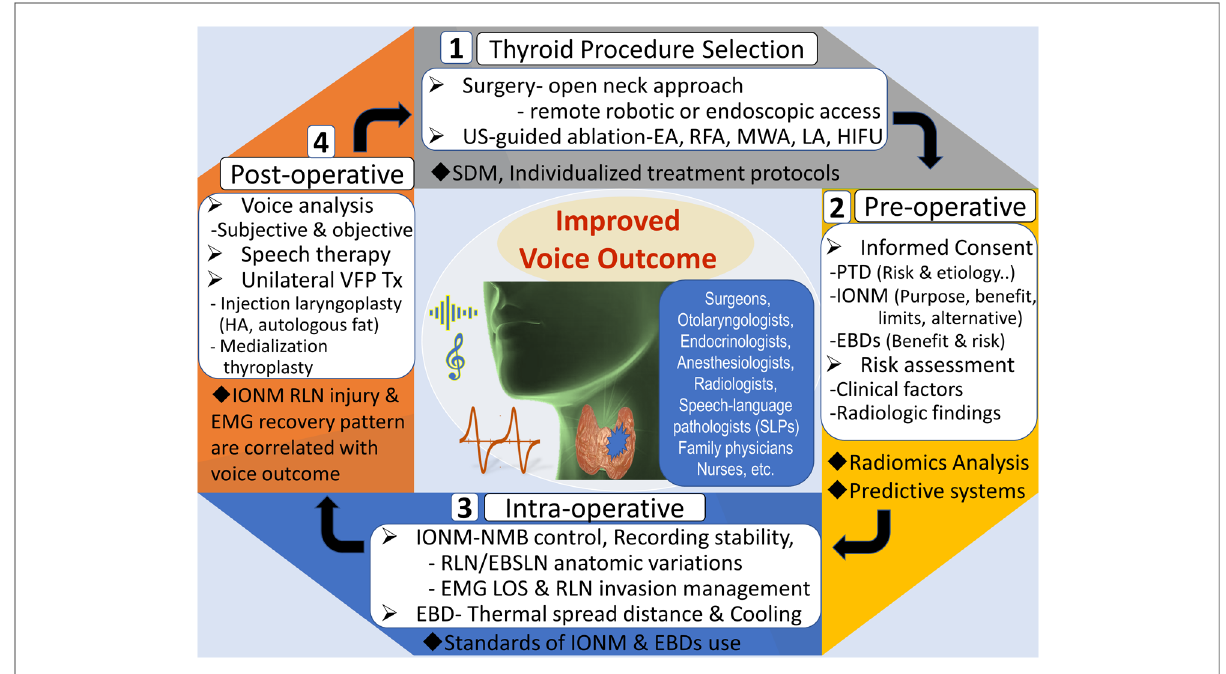
FIGURE 1 The use of a multifaceted approach to improve voice outcomes after thyroid surgery and ultrasound-guided ablation procedures. US, ultrasound; EA, ethanol ablation; RFA, radiofrequency ablation; MWA, microwave ablation, LA, laser ablation; HIFU, high-intensity focused ultrasound; SDM, shared- decision making, PTD, post-thyroid procedures dysphonia; IONM, intraoperative neural monitoring; EBDs, energy-based devices; NMB, neuromuscular block; RLN, recurrent laryngeal nerve; EBSLN, external branch of superior laryngeal nerve; EMG, electromyography; LOS, loss of signal; VFP, vocal fold paralysis; HA, hyaluronic